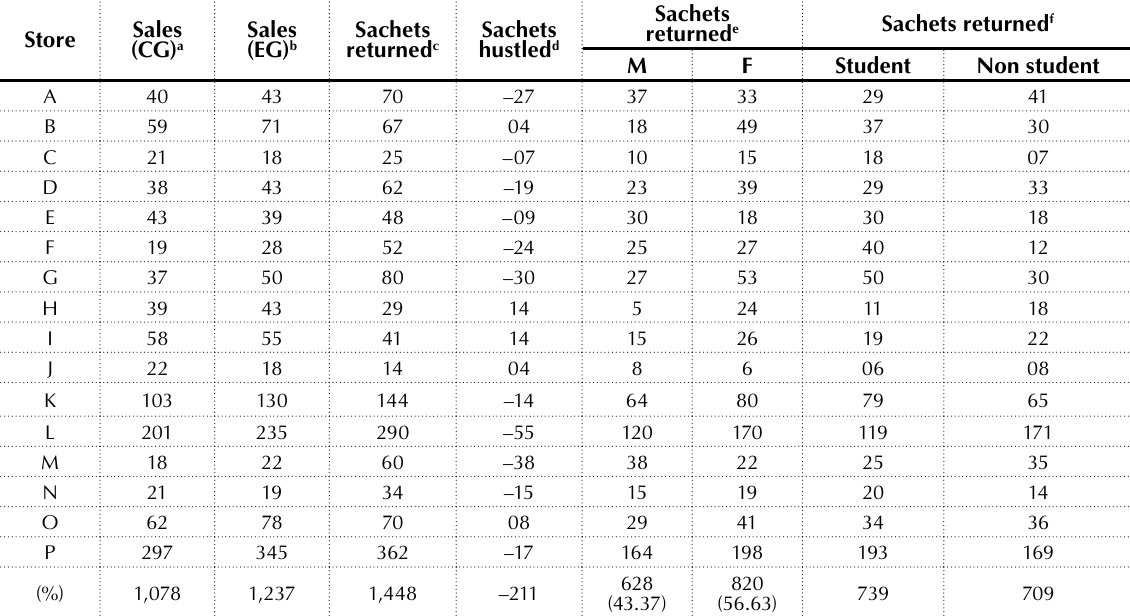
Table 4. Number of sachets purchased and returned by the experimental group